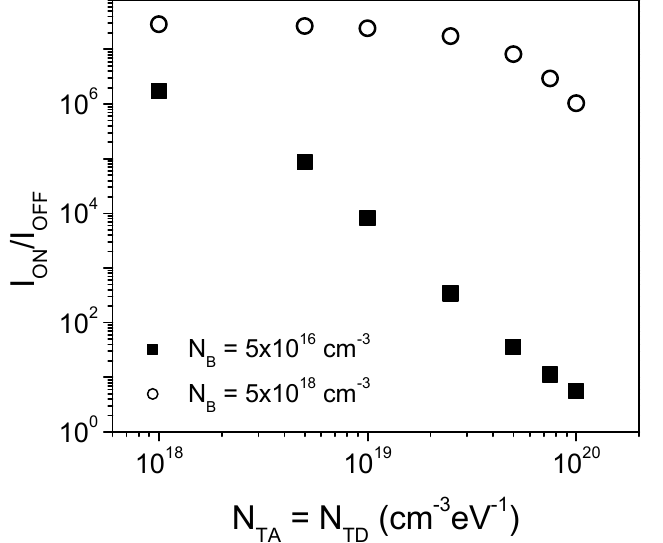
Figure 6. Comparison of the rectification ratio ( RR ) vs. the defect densities, for both N B values used in the simulations.